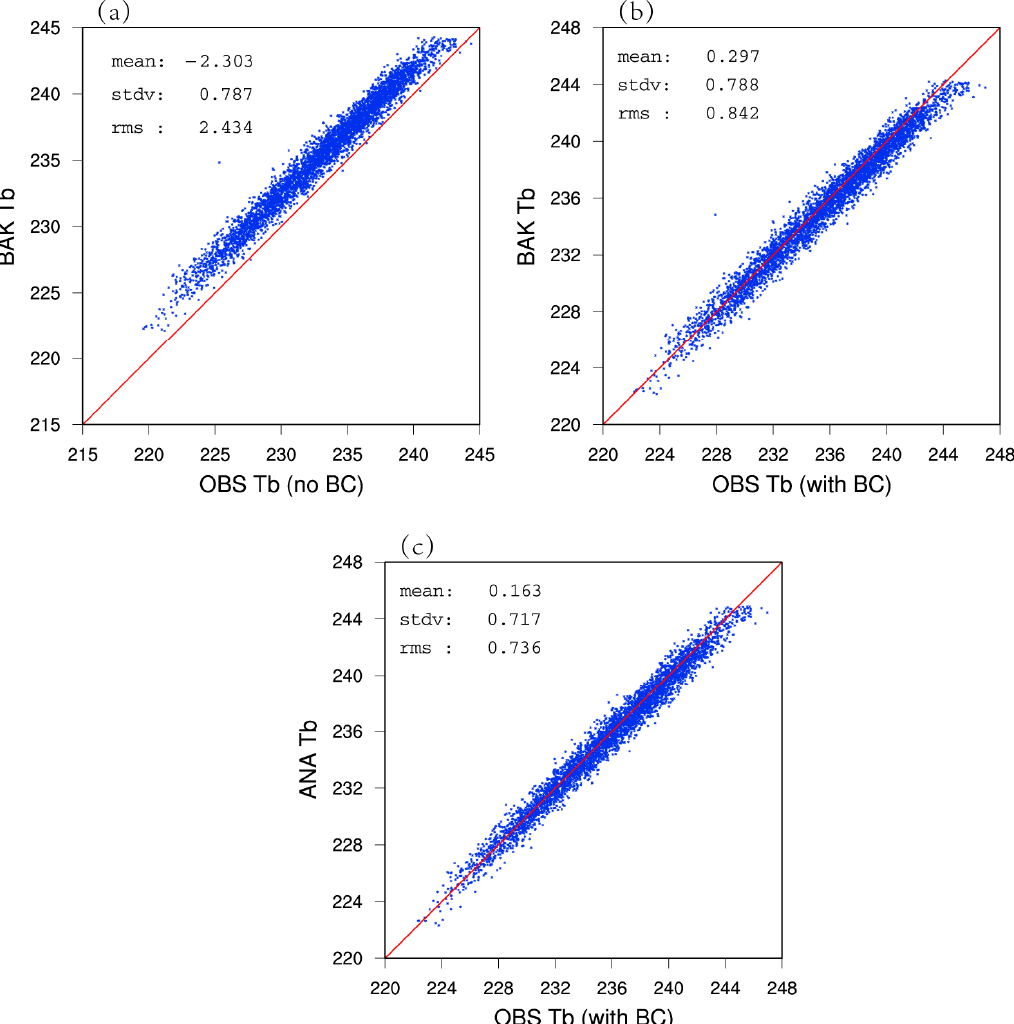
Figure 5. The scatter plots of channel 5 observed versus simulated brightness temperature (unit: K) of background ( a ) before the bias correction, ( b ) after the bias correction, and ( c ) observed versus simulated brightness temperature of the analysis.